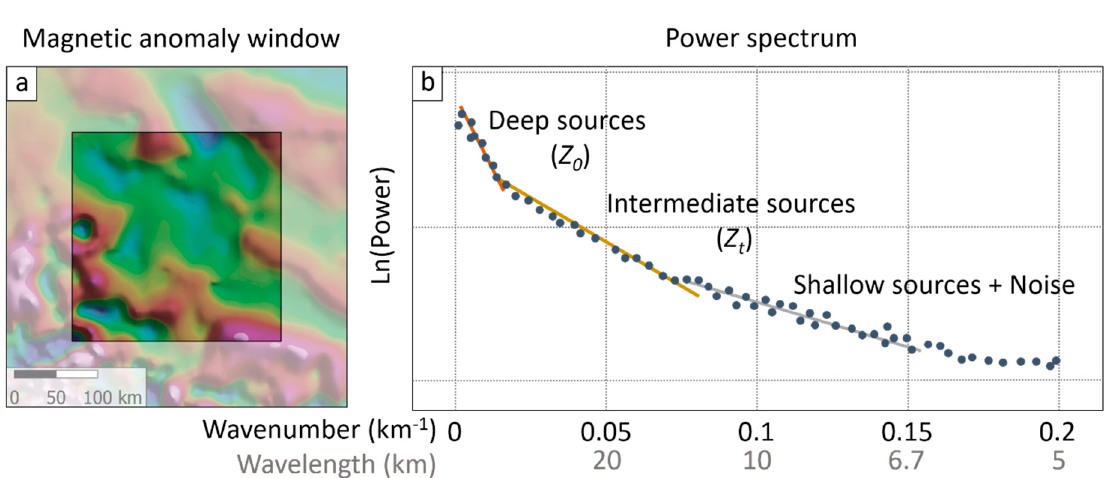
Figure 5. ( a ) Simplified sketch of the identification of the slopes of the intermediate and long wavelength magnetic anomalies from the power spectrum of magnetic anomalies within a single magnetic window ( b ). For illustration, small circular anomalies in the magnetic window ( b ) would correspond to shallow sources in the power spectrum, whilst larger anomalies would correspond to intermediate and deep sources.